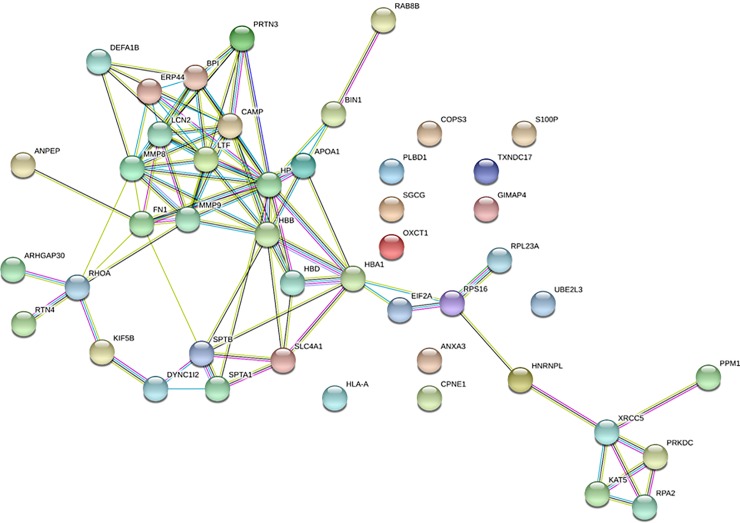
Relationship network analysis.Molecular Interaction network of the proteins differentially expressed in the PBMCs from CVD and their controls individuals, was constructed using STRING software and showed a direct connection between most of the proteins affected by CVD. Network nodes represent proteins, edges represent protein-protein associations and line thickness indicates the strength of data support. Color codes are for interactions based on: curated databases (turquoise), experimentally determined (purple), gene neighbourhood (green), gene fusions (red), and gene co-occurrence (blue).